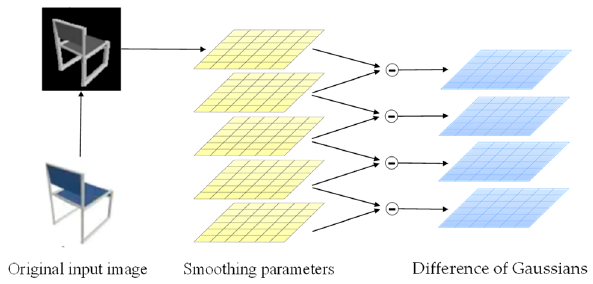
Figure 6. DOG processing of input picture.